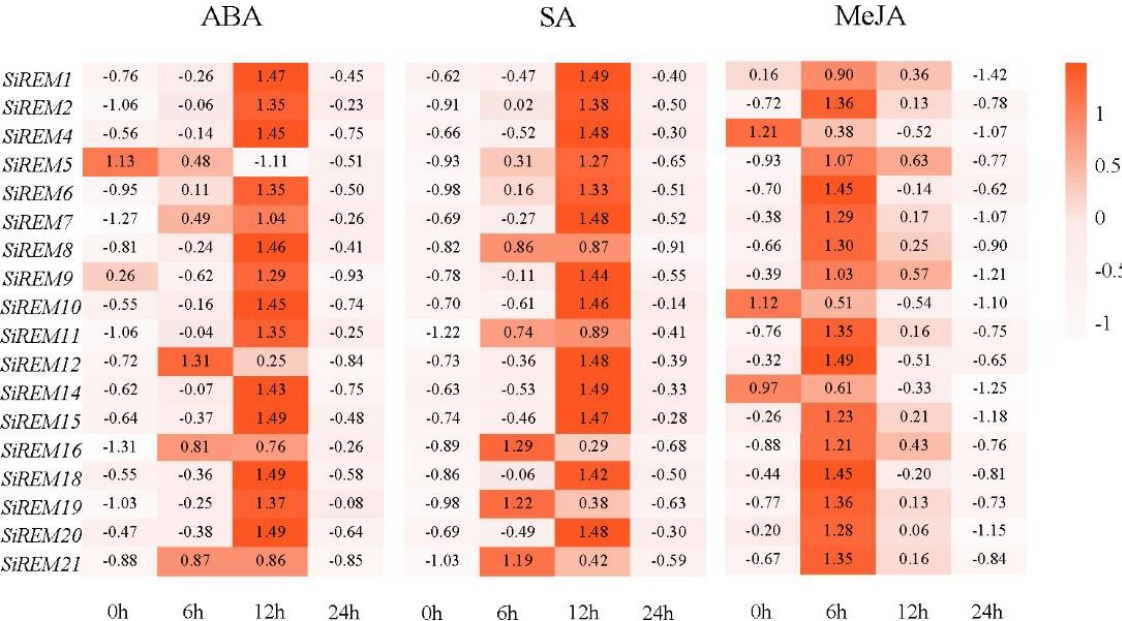
Figure 7. Expression profile of SiREM genes under different abiotic stress conditions. Orange bars indicate up-regulation, white bars indicate down-regulation, and the intensity of the color indicates the intensity of expression. 4. Discussion Remorin family genes